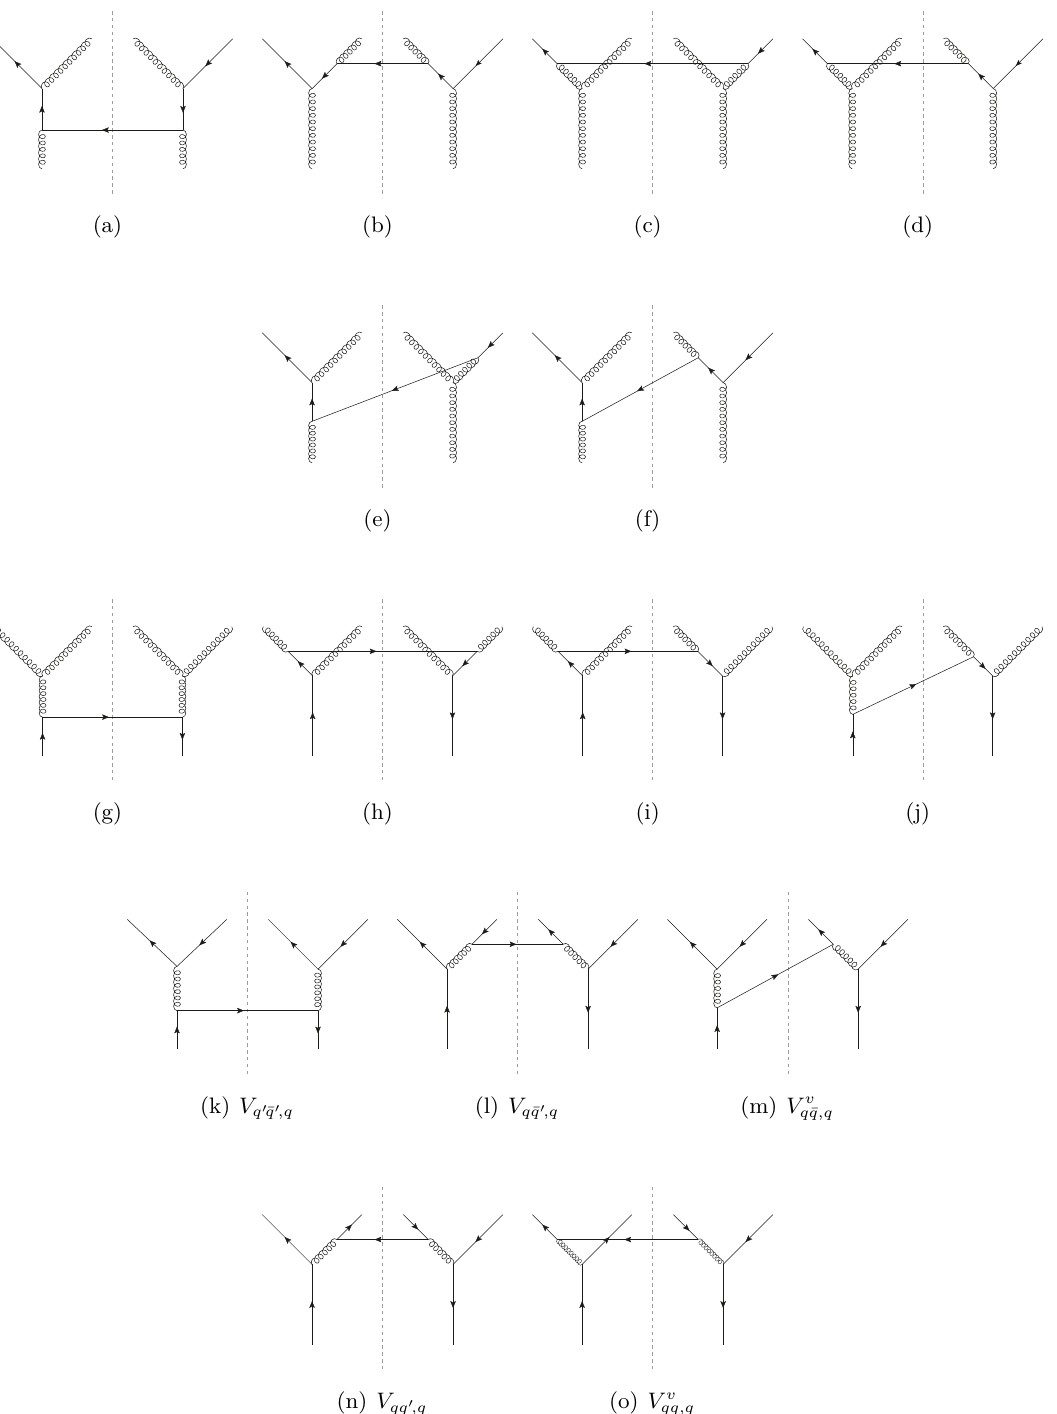
Figure 4 . Real graphs for NLO channels. Additional graphs are obtained by interchanging a 1 ↔ a 2 and by reflection w.r.t. the final state cut. The association of parton lines is as in figure